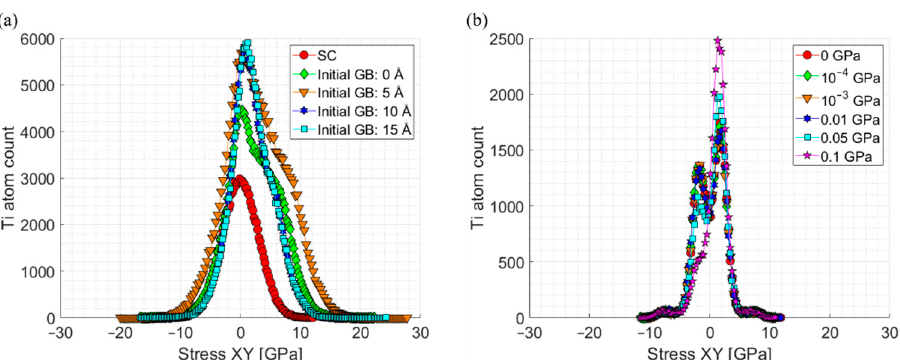
Figure 12. Atomic stress XY distribution in simulation domains. Data points were obtained from the histogram distribution of Ti atoms: ( a ) Elastic modulus cases ( b ) Phase transformation temperature cases.